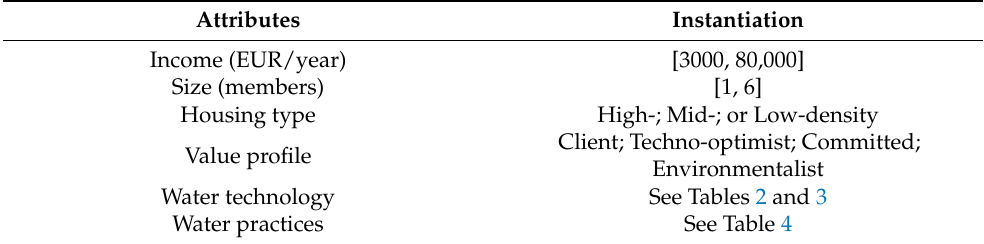
Table 1. Household